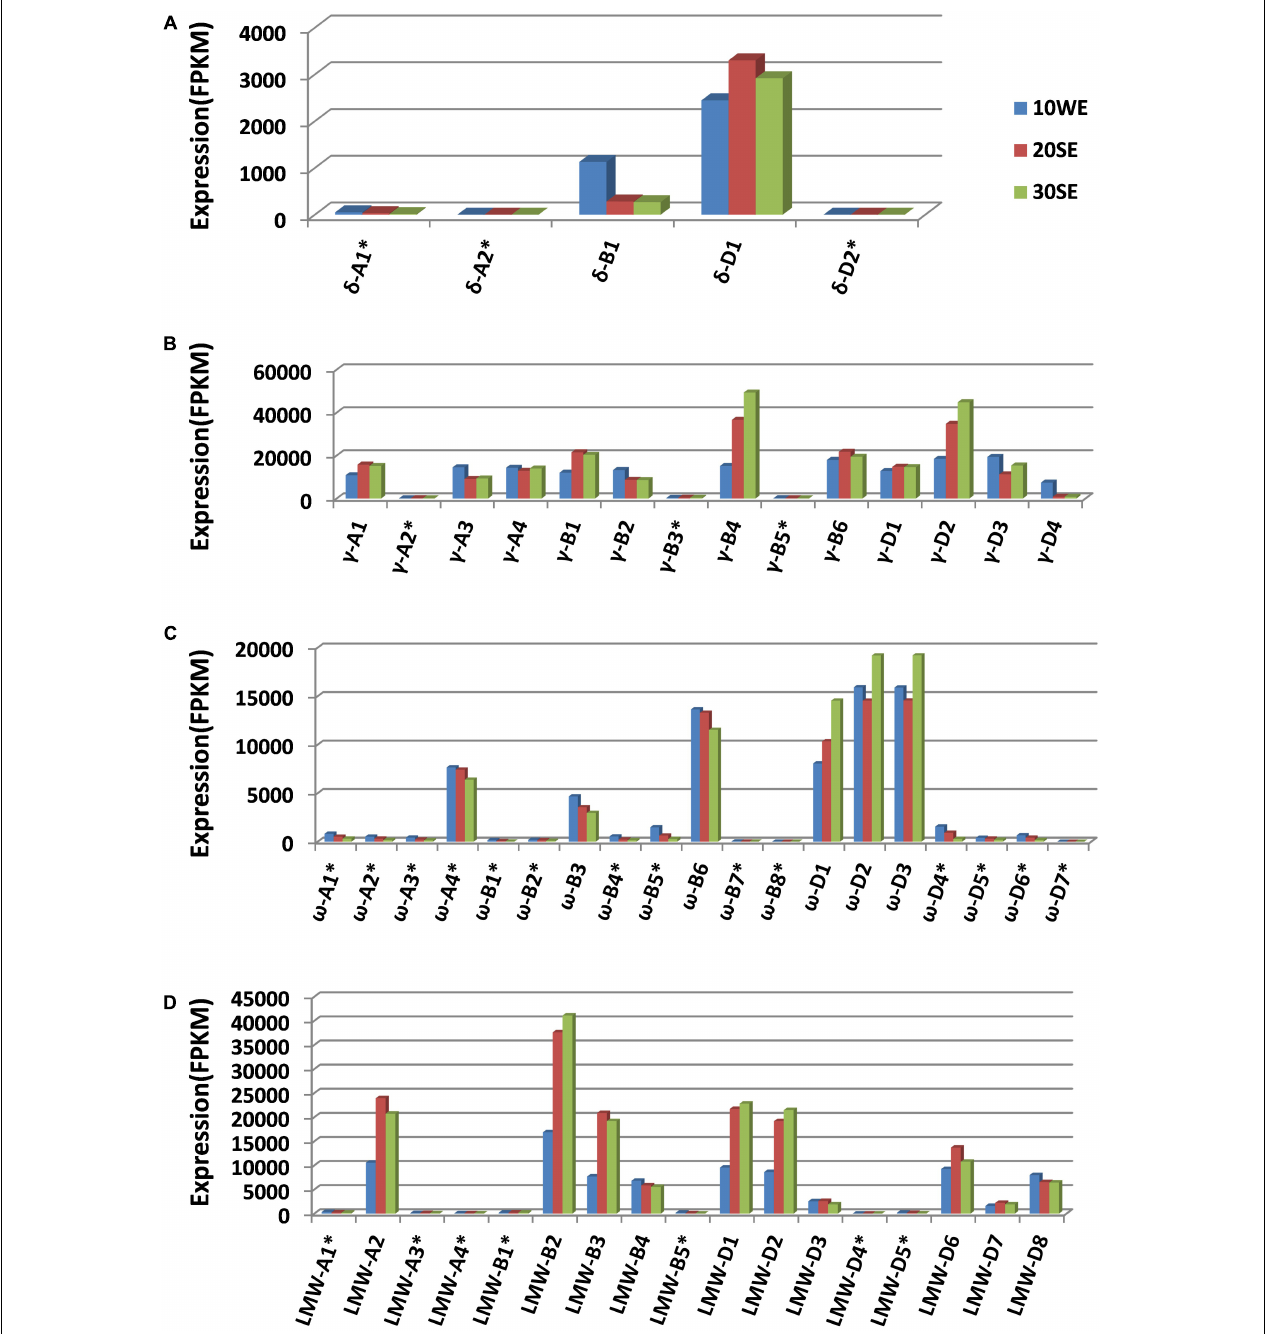
FIGURE 4 | Expression profiles of different groups of prolamin genes ( A for γ -gliadin, B for δ -gliadin, C for ω -gliadin, and D for LMW-GS). Transcriptome datasets generated from different grain development stages were downloaded from the published result (Pfeifer et al., 2014). 10WE represents whole endosperm at 10 days post-anthesis, 20SE, starchy endosperm at 20 days post-anthesis, 30SE, starchy endosperm at 30 days post-anthesis. For expression profiling, CLC genomic workbench RNA-seq analysis toolbox was used to map transcriptome reads to the complete annotated wheat gene set (Clavijo et al., 2017) with the prolamin genes replaced with the prolamin gene set annotated in this study. FPKM values were calculated using the functions in the toolbox. Pseudogenes are indicated with ∗ .